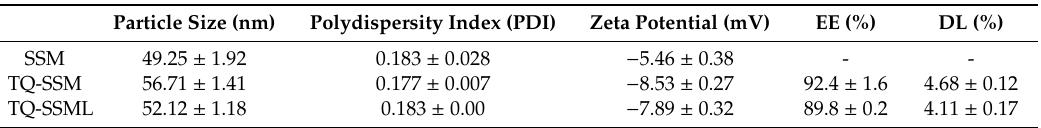
Table 1. Physical and chemical properties of empty SSM and TQ-SSM. All values are expressed as means ± standard